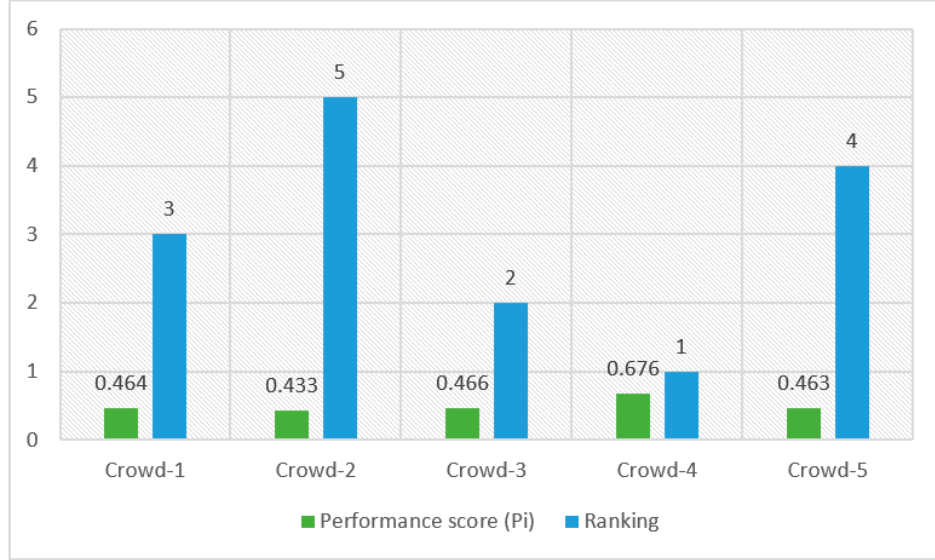
Figure 3. Ranking and performance of alternatives .